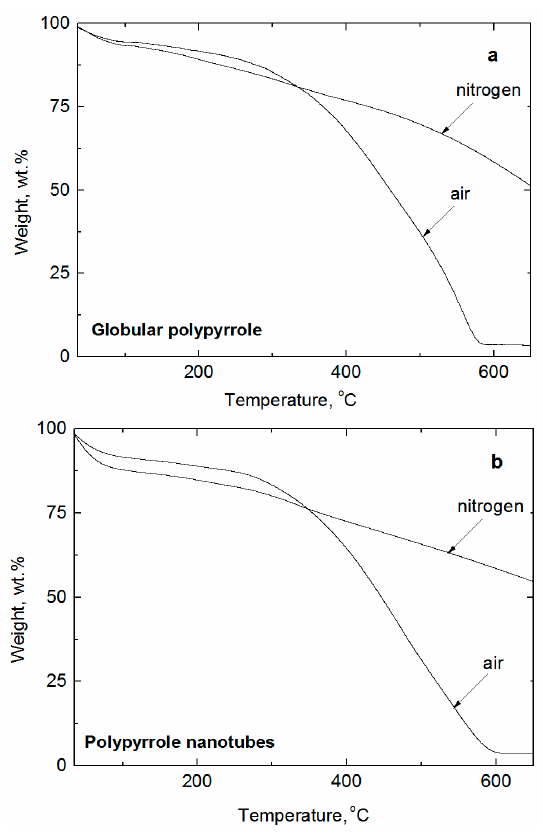
Figure 3. Thermogravimetric analysis of ( a ) globular polypyrrole and ( b ) polypyrrole nanotubes in air and in nitrogen.